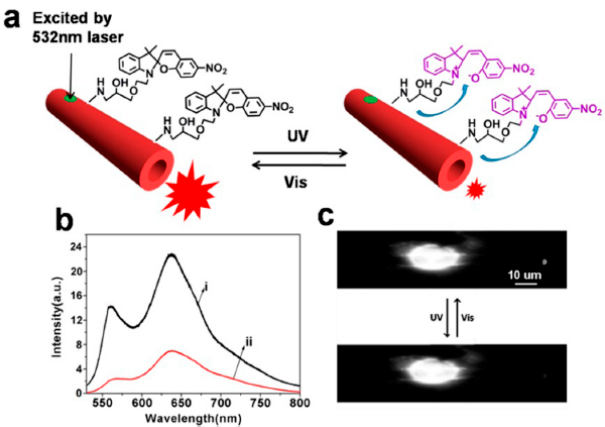
Figure 12. ( a ) Modulation of waveguiding in a PDA microtube. ( b ) Tip emission spectra of the microtube after irradiation with visible light and UV light. ( c ) Fluorescence microscopy images collected upon excitation of the same microtube following UV and visible light irradiation (the whole Figure 12 was reprinted with permission from Xia et al. [56]).